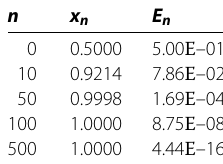
n x n E n 0 0.5000